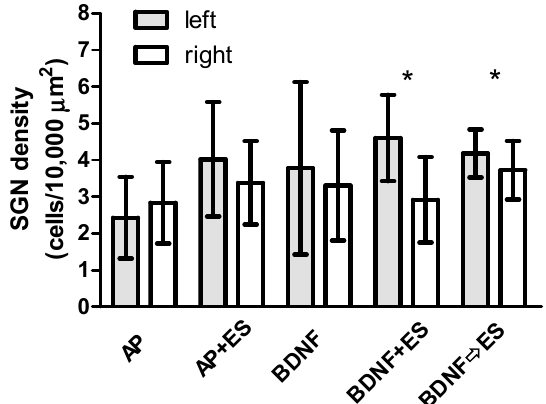
Figure 4. Threshold shifts between days 21 and 48 for groups AP + ES ( A ), BDNF + ES ( B ), and BDNF ⇨ ES ( C ). Provided are the individual developments of the hearing thresholds for all animals. The hearing threshold decreased in all electrically stimulated animals except one in the BDNF + ES group ( B ).